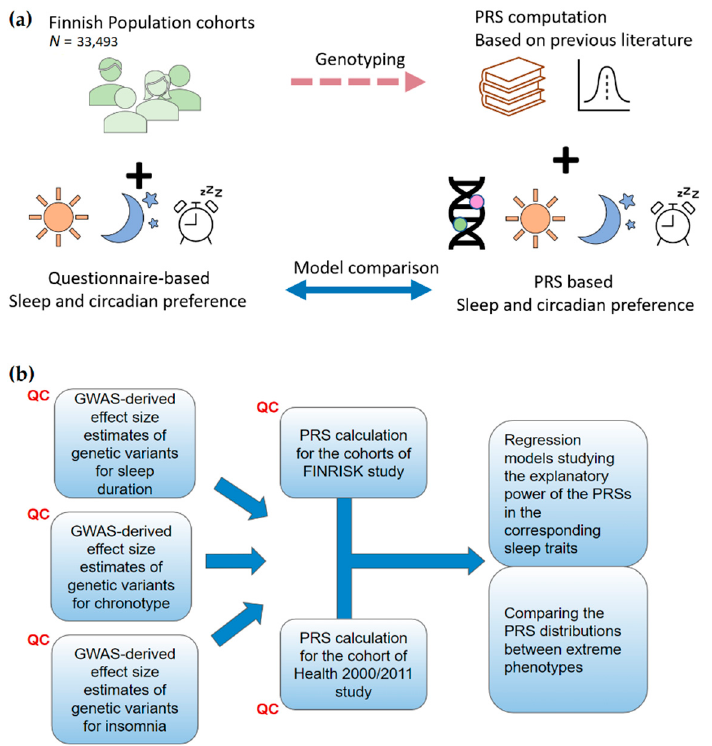
Figure 1. ( a ) A schematic diagram of the workflow of the study. ( b ) Analytical workflow, including quality control (QC) of the